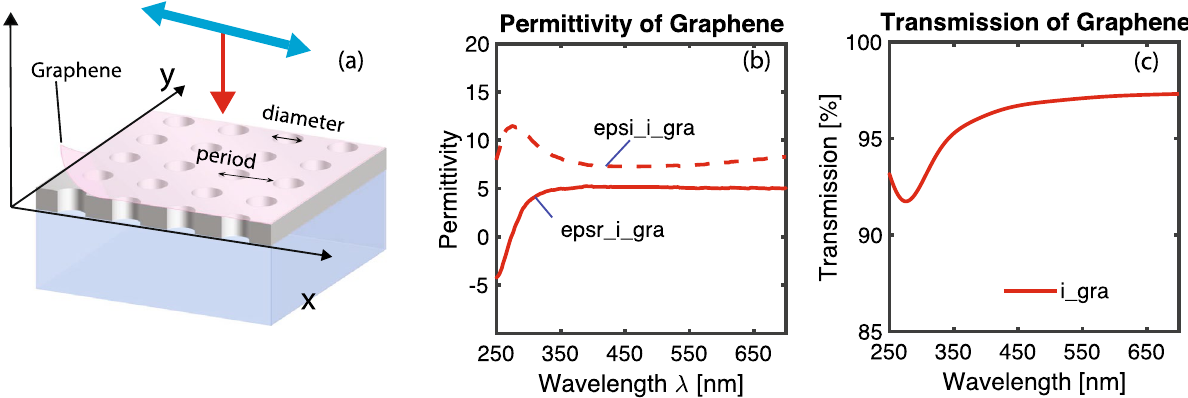
Figure 1. ( a ) A schematic diagram showing graphene on top of a metallic hole-array. ( b ) Real and imaginary permittivity of an intrinsic graphene. ( c ) Transmission spectrum through a free-standing intrinsic